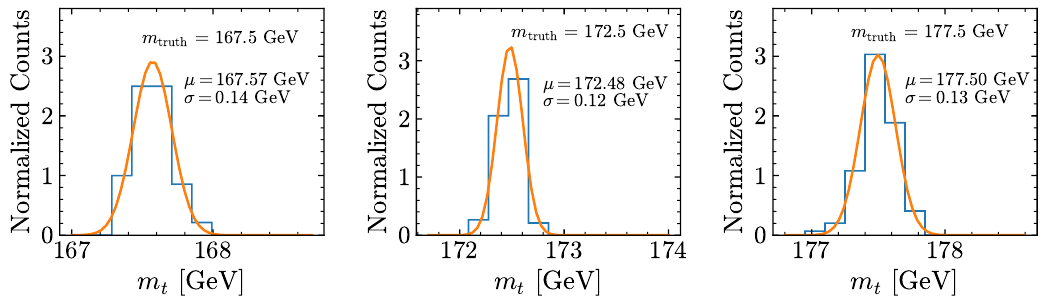
Figure 14 . All-hadronic template closure tests for m t =167.5 GeV, 172.5 GeV and 177.5 GeV. The distribution of bootstrapped results are given by the histogram, along with an accompanying Gaussian (cid:12)t, whose mean and standard deviation are inset within each panel.